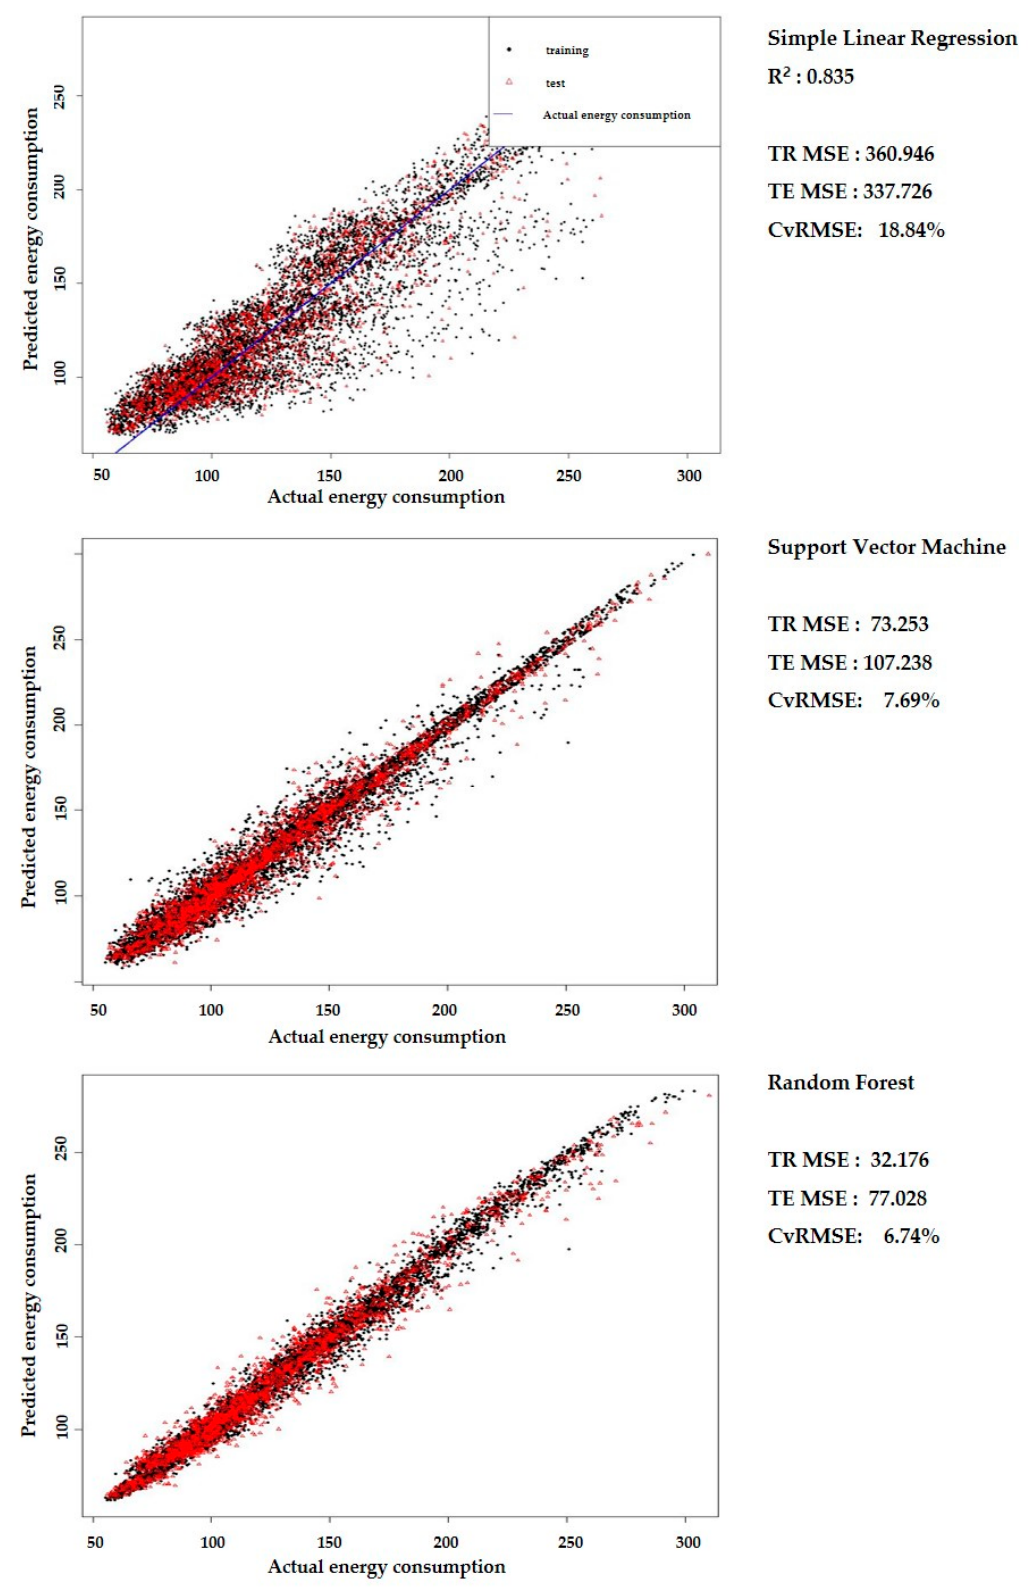
Figure 10. Results of the simple linear regression, support vector machine, and random forest analyses using the original variables.